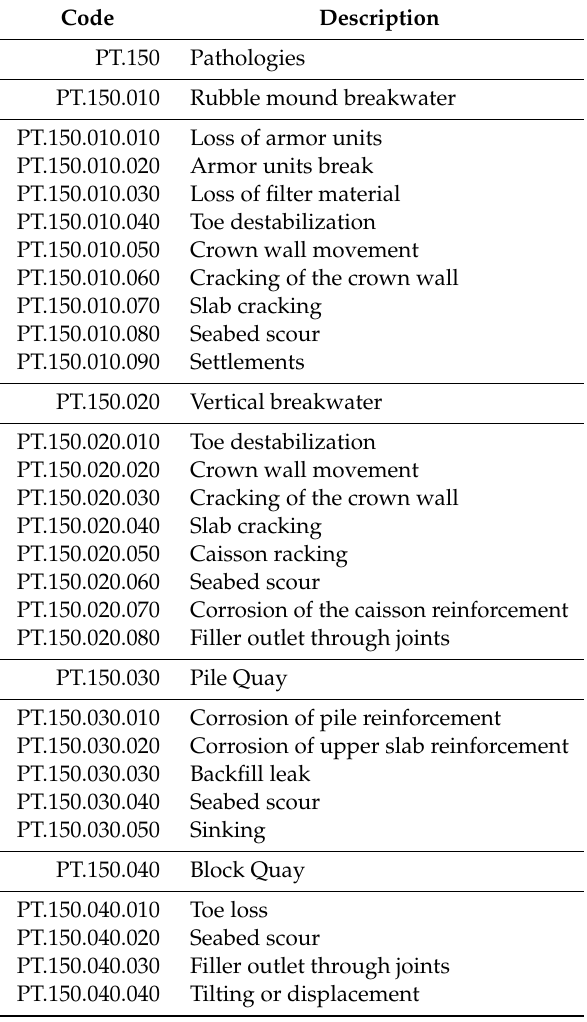
Table 2. Proposal to expand the Puertos del Estado Classification